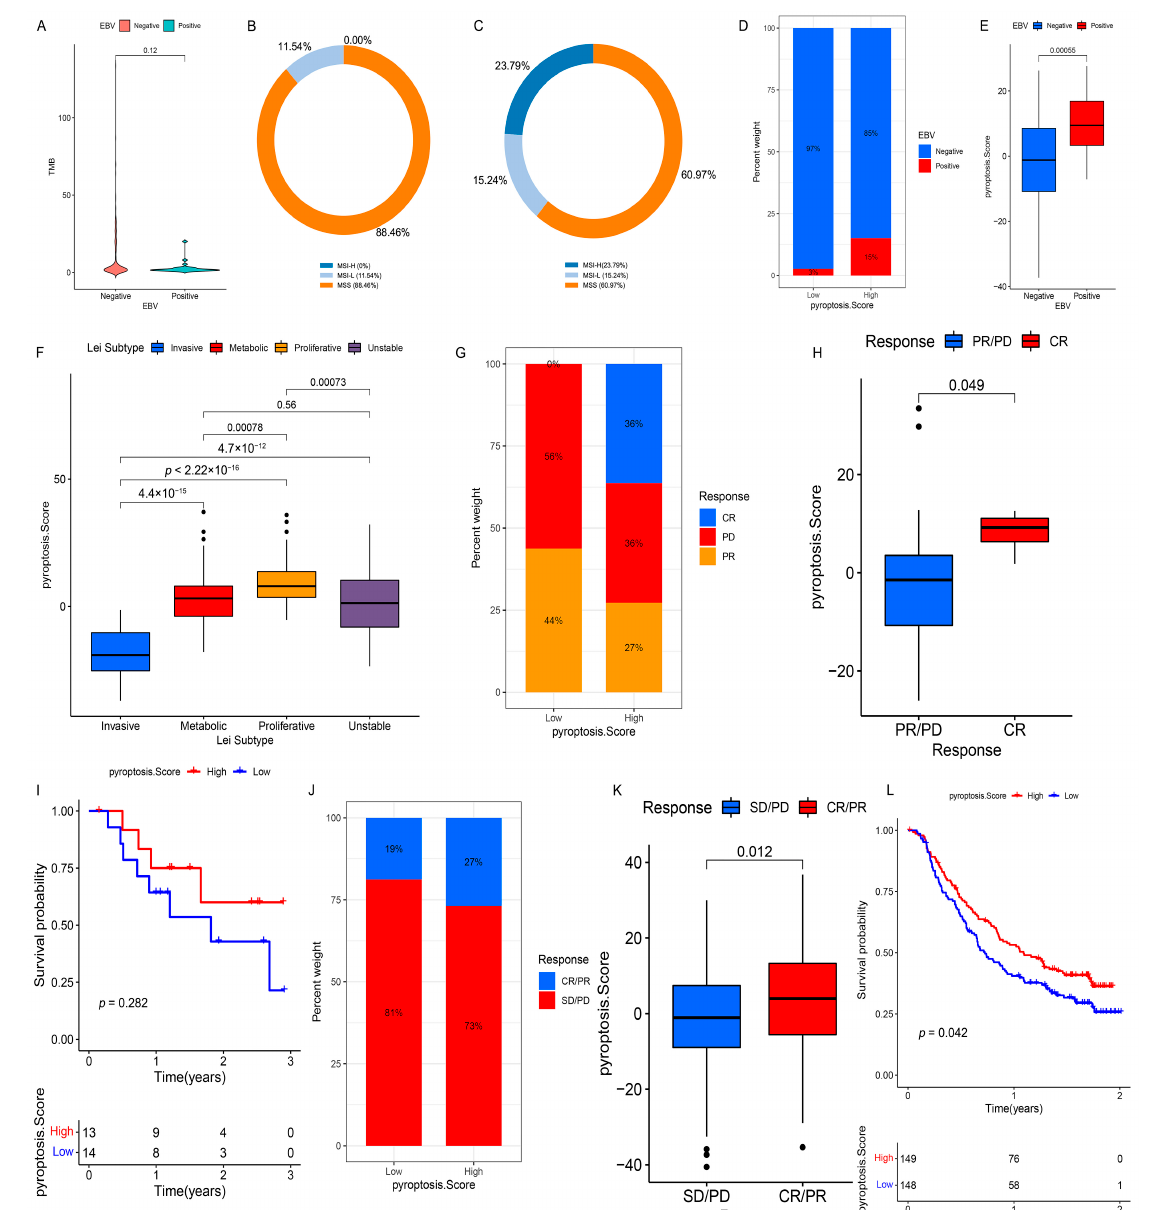
Figure 8. Clinical relevance of the PS and its role in predicting anti-PD-1/L1 immunotherapy. ( A ) Differences in the TMB among patients with different EBV infection statuses in the TCGA cohort. ( B,C ) The proportion of MSI-H, MSI-L, or MSS subtypes in the EBV-positive group ( B ) and EBV-negative group ( C ) in the TCGA cohort. ( D ) The fraction of patients with different H. pylori infection statuses in the low- or high-PS subgroups in the TCGA cohort. ( E ) Differences in the PS among patients with different H. pylori infection statuses in the TCGA cohort. ( F ) Differences in the PS among patients with Lei subtypes in the GSE15459 and GSE34942 datasets. ( G ) The fraction of patients with a clinical response to anti-PD-1 immunotherapy in the low- or high-PS subgroups in the GSE78220 dataset. CR vs. PR/PD: 36% vs. 64% in the high-PS group and 0% vs. 100% in the low-PS group. ( H ) Differences of the PS in distinct anti-PD-1 clinical response subgroups in the GSE78220 dataset. ( I ) Survival analysis for the low- and high-PS subgroups in anti-PD-1 immunotherapy using Kaplan–Meier curves (GSE78220 dataset: p = 0.282, Log-rank test). ( J ) The fraction of patients with a clinical response to anti-PD-L1 immunotherapy in the low- or high-PS subgroups in the IMvigor210 cohort. CR/PR vs. SD/PD: 27% vs. 73% in the high-PS group and 19% vs. 81% in the low-PS group. ( K ) Differences of the PS in distinct anti-PD-L1 clinical response subgroups in the IMvigor210 cohort. ( L ) Survival analysis for the low- and high-PS subgroups in anti-PD-L1 immunotherapy using Kaplan–Meier curves (IMvigor210 cohort: p = 0.042, Log-rank test). CR, complete response; PR, partial response; SD, stable disease; PD, progressive